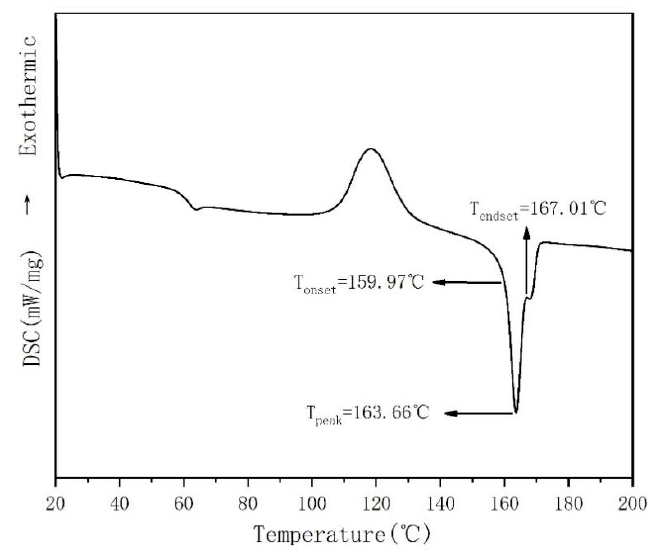
Figure 3. DSC second heating curve of PLA.